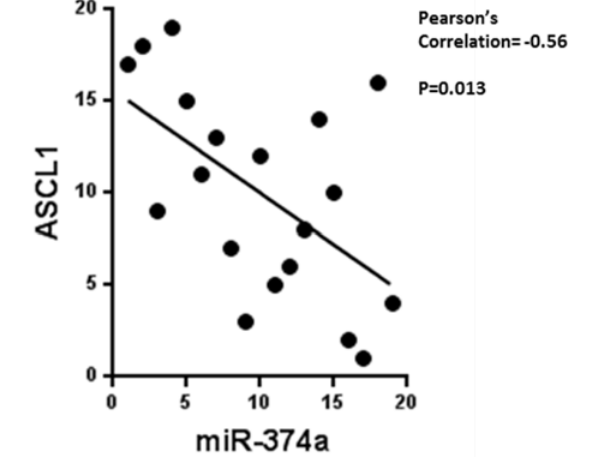
Fig 5. Correlation between miR-374a and ASCL1. Quantitative RT-PCR for miR-374a and ASCL1 were performed in each individual ’ s peripheral airway epithelial cells (n = 17 cancer patient and n = 13 smoker controls) to confirm miRNA-mRNA negative correlation in the array. We confirm that ASCL1 expression was negatively correlated with miRNA-374a expression in peripheral airway epithelial cells (Pearson ’ s = -0.56, p =